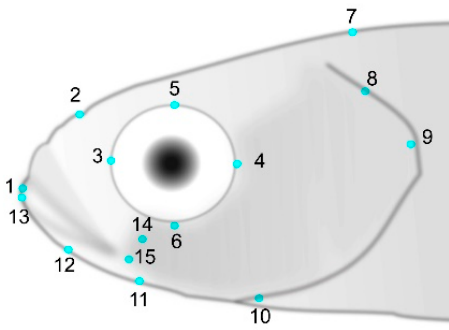
Figure 1. 15 homologous anatomical points (landmarks) used to visualize shape differences among the specimens analysed: 1, snout tip; 2, nostril; 3, orbit, anterior margin along longest axis; 4, orbit, posterior margin along longest axis; 5, orbit, dorsal margin along longest axis; 6, orbit, ventral margin along longest axis; 7, dorsal margin of the epaxial muscle; 8, joint between post-temporal and supra-temporal bone; 9, operculum margin; 10, depression of the sternohyoid muscle; 11, posterior margin of the maxilla; 12, midpoint of the mandible; 13, upper posterior maxilla; 14, lower posterior maxilla; 15, posterior margin of the mandible.